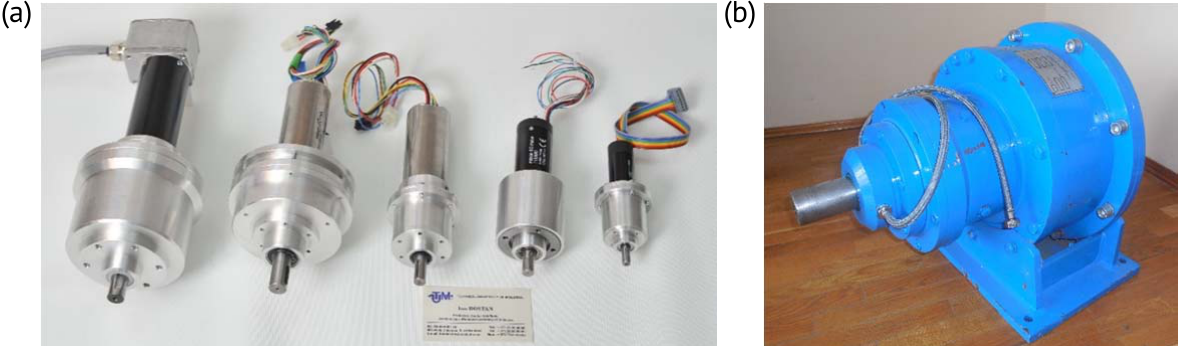
Figure 13. A series of kinematic precessional reducers with gears with convex-concave contact of the teeth (a) and submersible precessional power-reducer